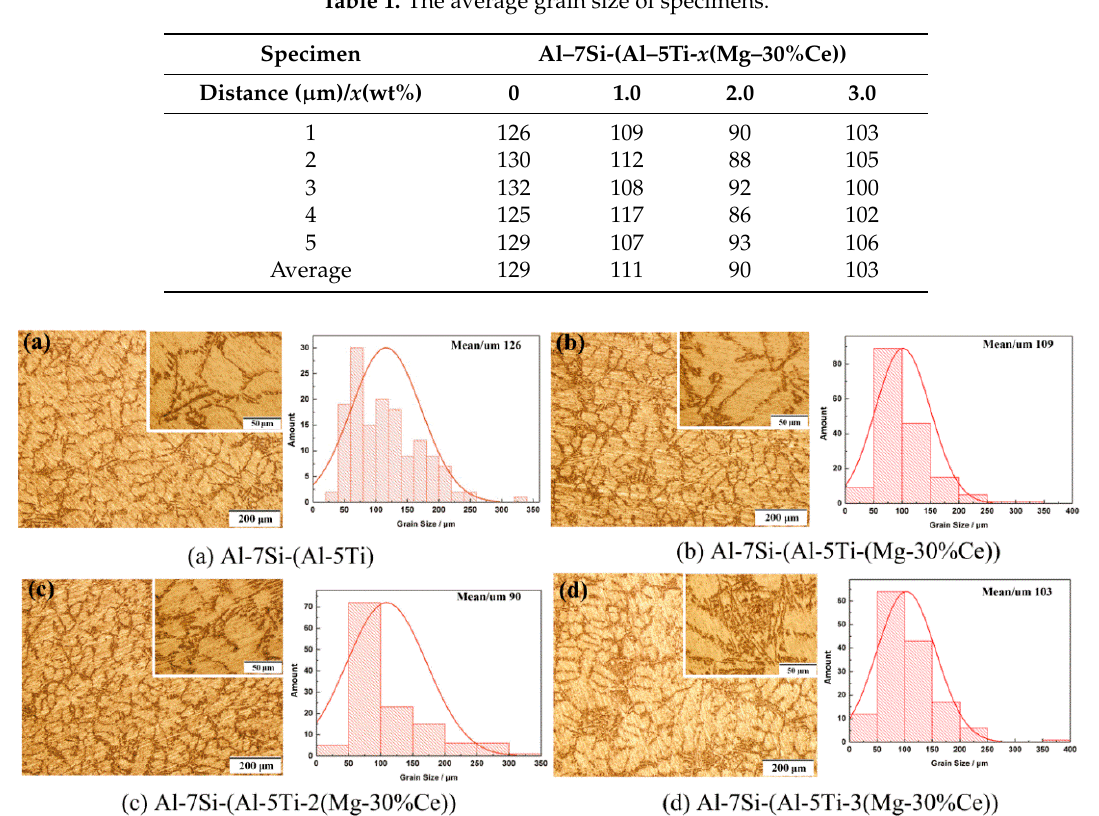
Figure 7. Metallographic micrograph images of the Al–Si alloy (100×).